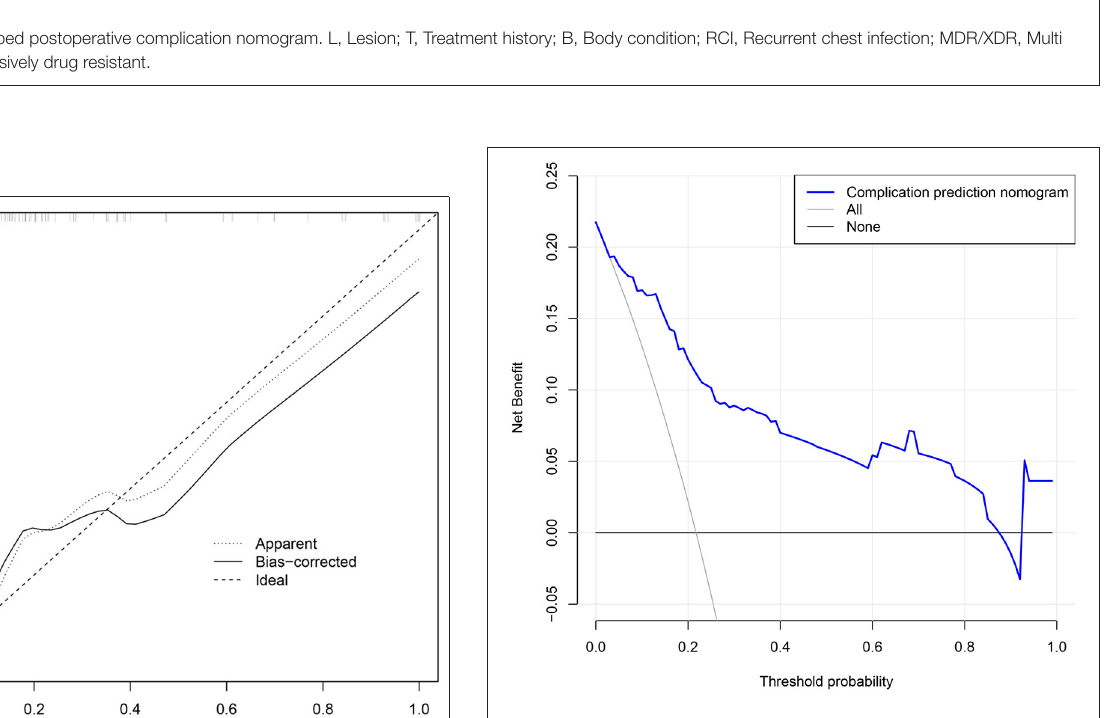
FIGURE 4 | Decision curve analysis for the nomogram. The y-axis measures the net benefit. The blue line represents the postoperative complication risk nomogram. The thin solid line represents the assumption that all patients get complication after surgery. Thin thick solid line represents the assumption that no patients get complication after surgery. The decision curve showed that if the threshold probability of a patient and a doctor is 4 and 86%, respectively, using this nomogram in the current study to predict postoperative complication risk adds more benefit than the intervention-all-patients scheme or the intervention-none